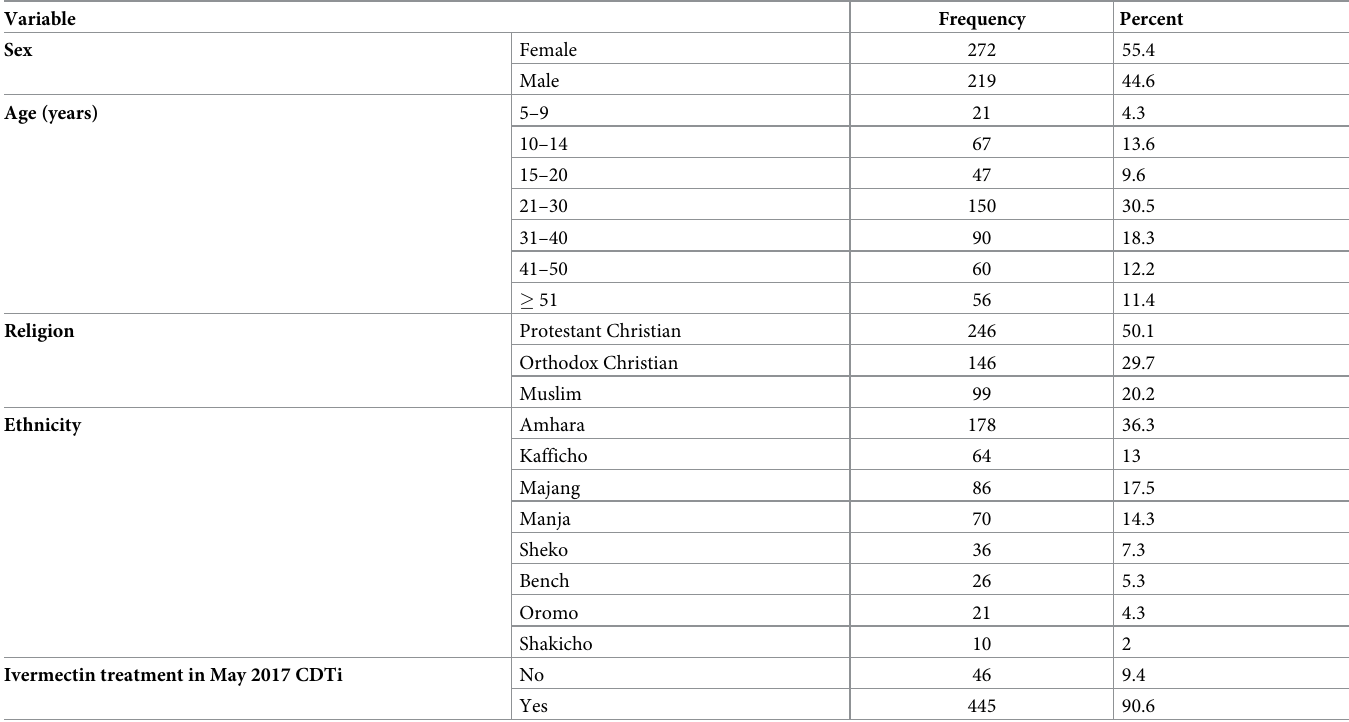
Table 1. Socio-demographic characteristics of the study participants from Yeki district of southwest Ethiopia (2017).